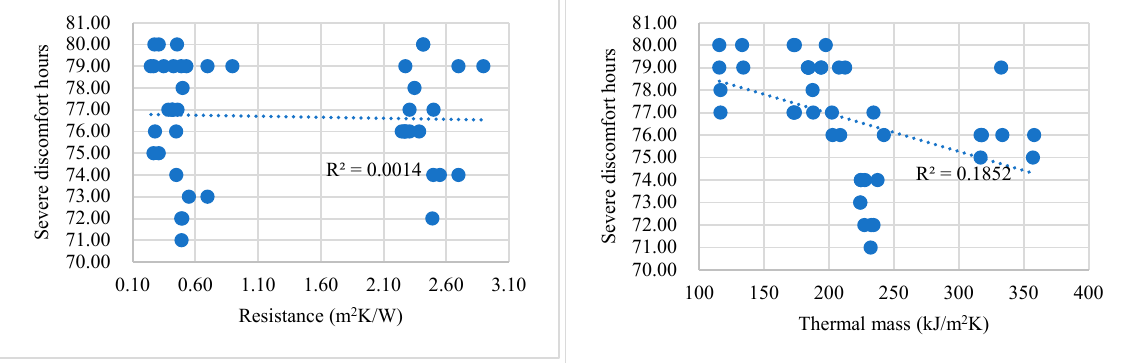
Figure 9. Severe discomfort hours with resistance and storage.